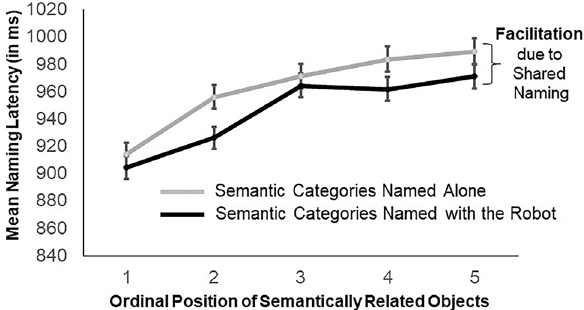
Figure 2. Naming latencies in the naming task with a robot partner. Mean naming latency and standard errors (in milliseconds) observed in the current experiment with a robot partner, broken down by ordinal position and naming condition. Faster naming latencies for semantic categories named with the robot (Shared Naming) as compared to semantic categories named alone (Single Naming) point to a facilitatory effect of sharing the naming task with the robot on speaking.